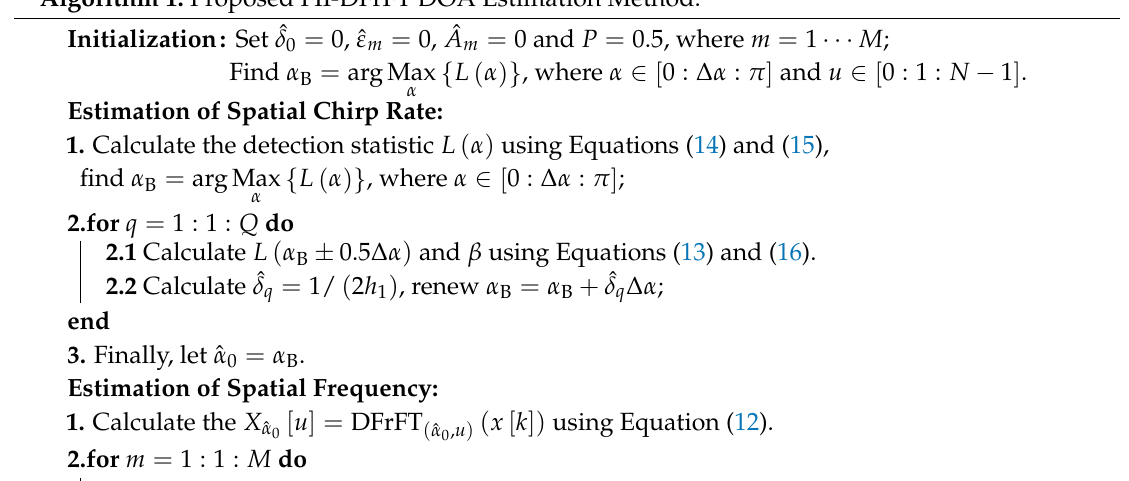
Algorithm 1: Proposed FII-DFrFT DOA Estimation